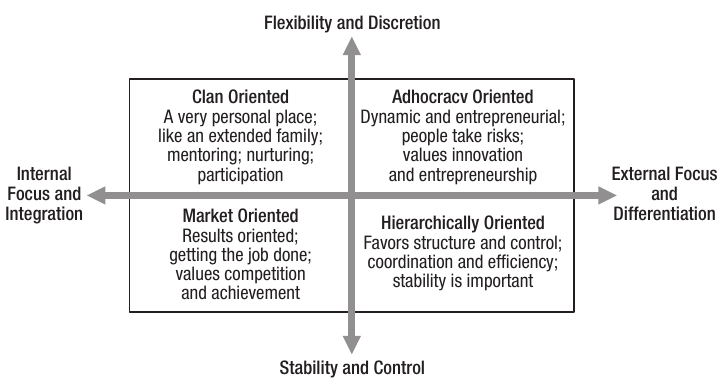
Fig. 1. Cultural profi les based on competing values